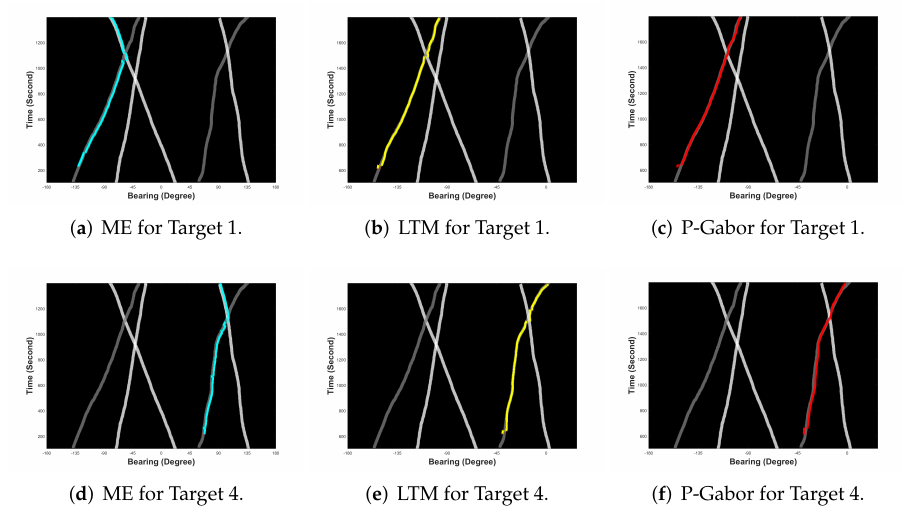
Figure 6. Experiment results with jamming targets.